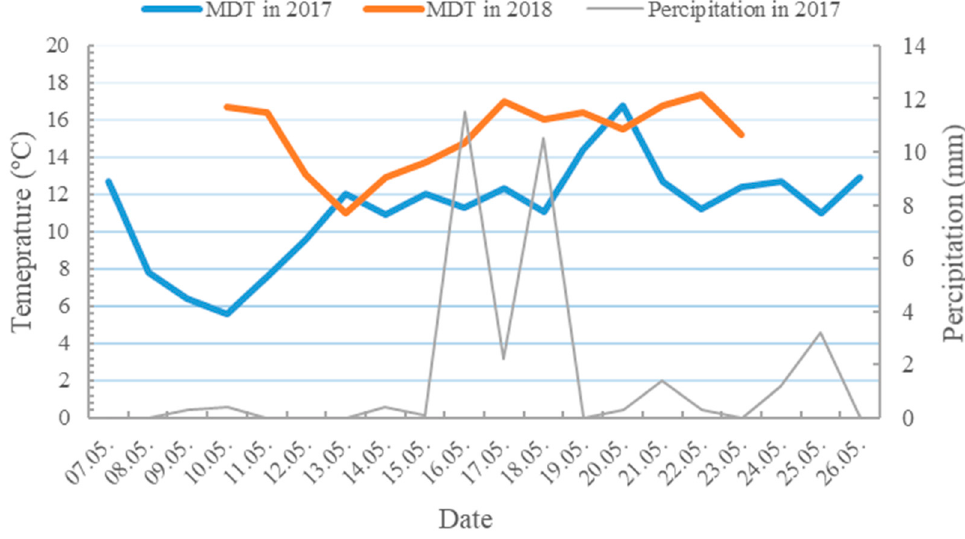
Figure 1. Two-year average of daily temperature and precipitation during the flowering of all studied pear cultivars. MDT—mean daily